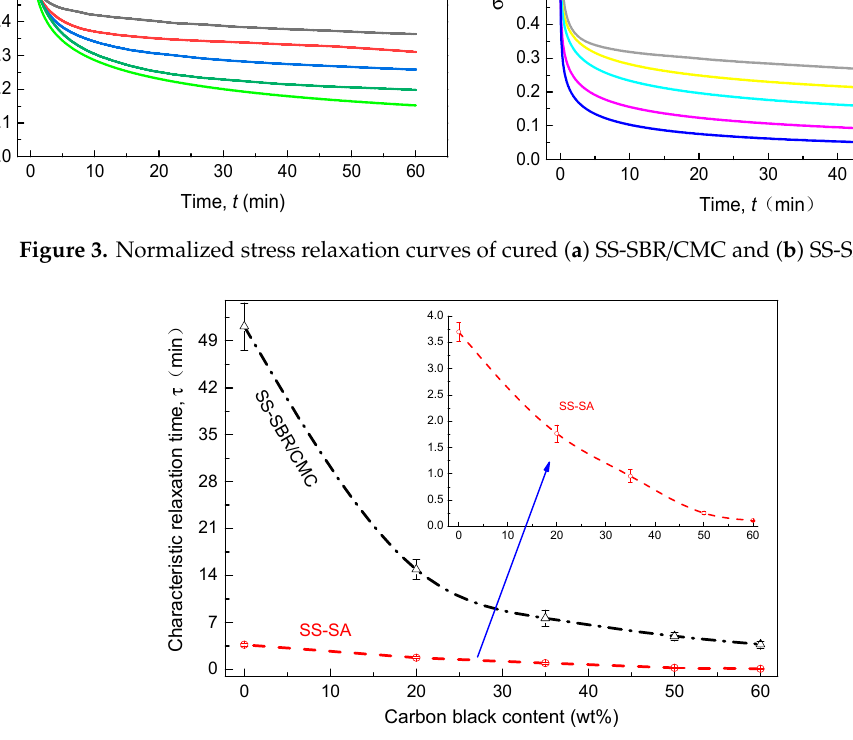
Figure 4. Evolution of the characteristic relaxation time of BCC films against carbon black content.